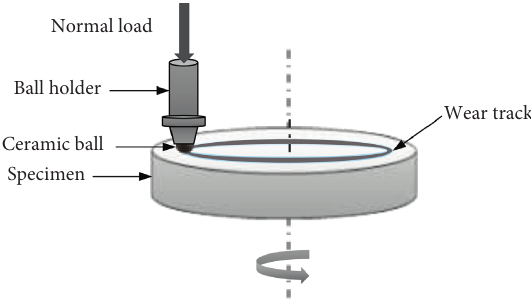
Table 3: The L 4 ) orthogonal array of cryogenic treatment. 9 (3 Exp. Figure 2: Schematic of the ball-on-disc wear